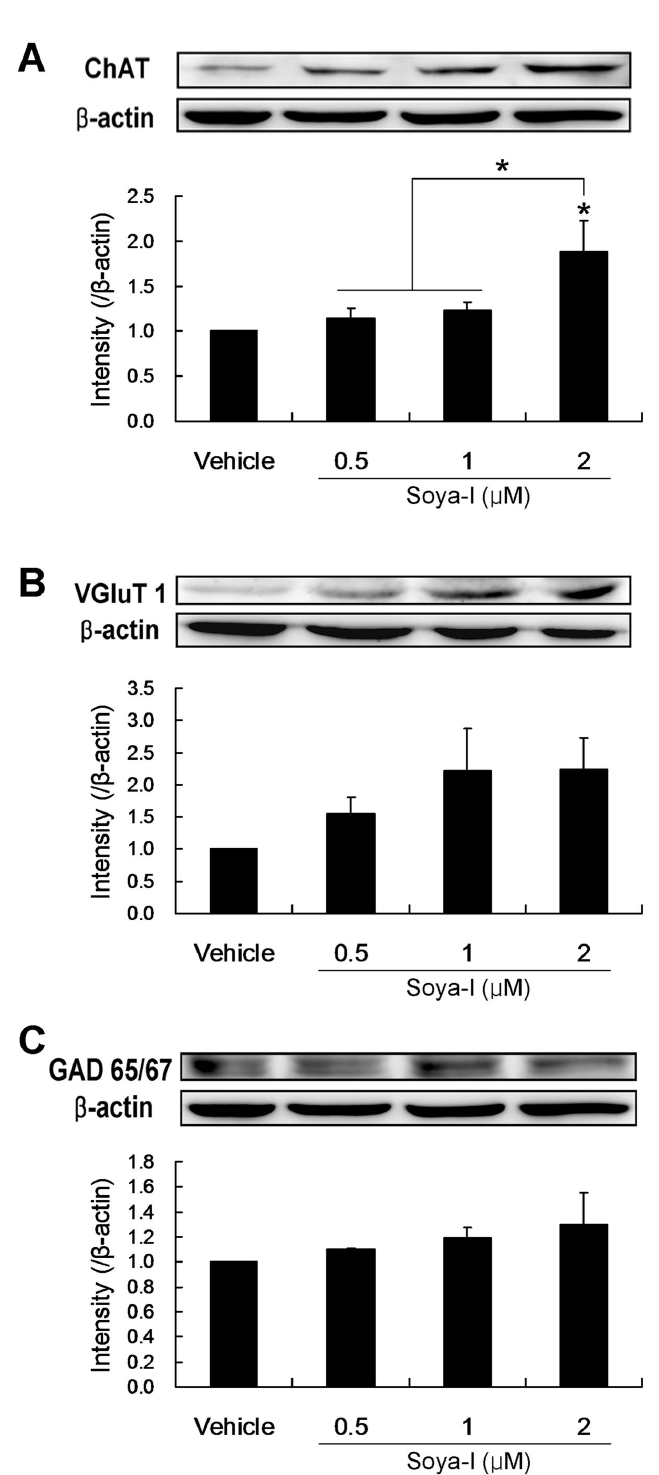
Figure 7. Effects of soya-Ι on expression of differentiation markers of neuronal cell types in cultured hippocampal cells. A. Effects of soya-Ι on the expression of ChAT protein. B. Effects of soya-Ι on the expression of VGluT1 protein. C. Effects of soya-Ι on expression of GAD 65/67 protein. All assay and measurements were carried out as described in Materials and Methods. Hippocampal cultures from the rat embryos were performed three times. Samples per groups were analyzed twice. Data represent means ± SEM ( * p < 0.05, compared with the vehicle group by Newman-Keuls Multiple Comparison Test). doi: 10.1371/journal.pone.0081556.g007 PLOS ONE |